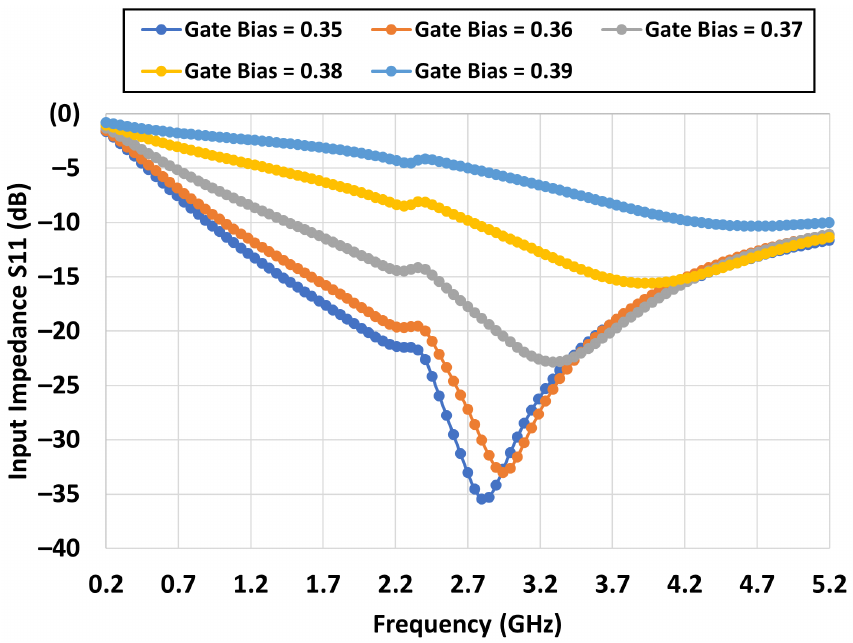
Figure 9. The input matching (S 11 ) versus frequency for several gate bias voltages of LNTA. It is important to optimize the gate biasing voltage of the mixer switches. Figure 10 shows the NF and conversion gain of the CRR front-end versus the gate biasing of the mixer switches. It shows a flat conversion gain and NF performance versus a wide rage of biasing from 0.6 V to 0.9 V, which is beneficial to compensate for bias variations.